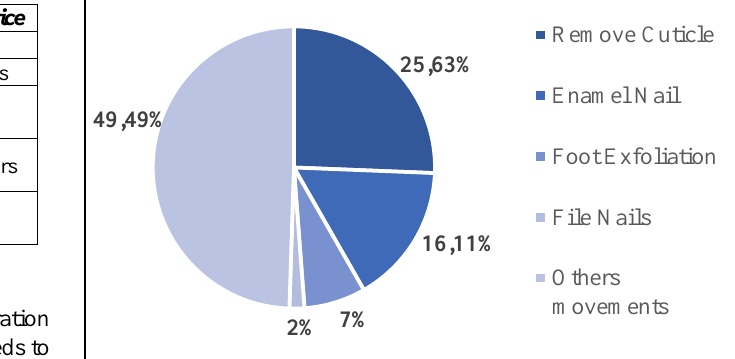
Table 4: Service x Operator's Movement.